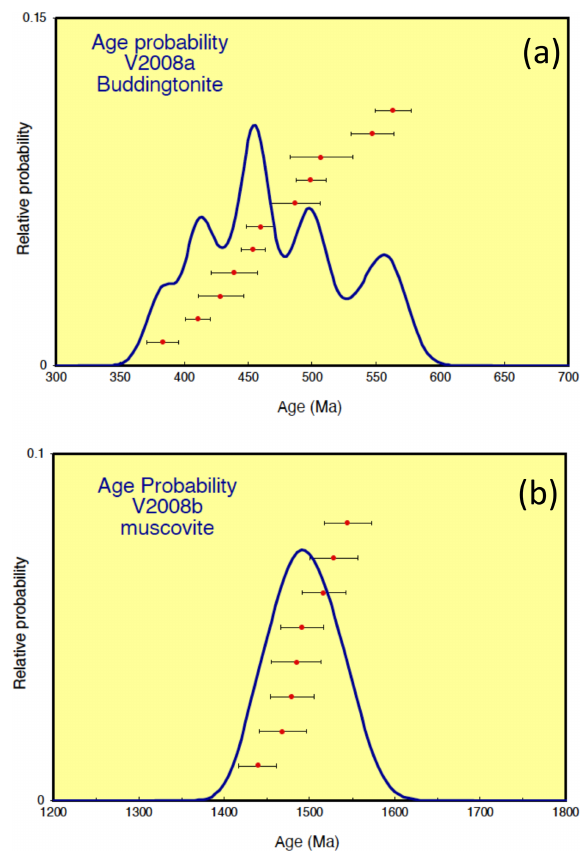
Figure 8. Results of 40 Ar/ 39 Ar dating for (a) buddingtonite and (b) muscovite. Whereas the muscovite ages show a restricted range varying from 1439 ± 22 to 1545 ± 28Ma, allowing the calculation of a mean age of 1491 ± 9Ma, the apparent buddingtonite ages ranging from 383 ± 12 to 563 ± 14Ma indicate significant resetting of the ages by Ar loss (calculation with decay constants from Steiger and Jäger, 1977; calculations with decay constant for 40 K by Renne et al., 2011, yielded maximal 5Myr older ages at 500Ma and max- imal 11Myr older ages at 1500Ma). The 1 σ errors include an error of J value (0.4%) and thus are external